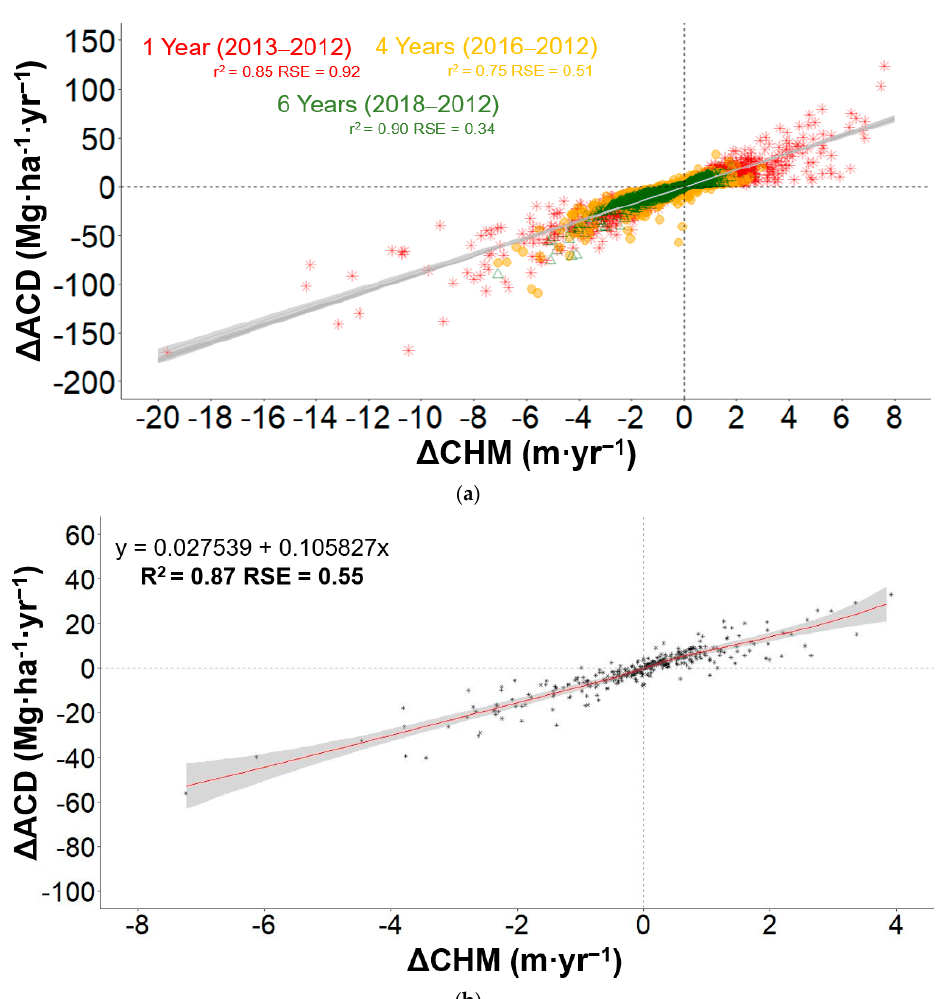
Figure 3. The scatter plots on the top shows the correlation between changes in height and changes in carbon for the periods analyzed ( a ). The coefficient of determination (R2) and the relative standard error (RSE) is presented for each period. Figure ( b ) shows the relative uncertainty, in which data were randomly selected across all the years analyzed. This approach was used to demonstrate the spread of the distribution around its expected value. The red line is the loess trends fit to the relation between Δ Carbon and Δ Height. The equation, R2, and RSE are also shown in the plot.